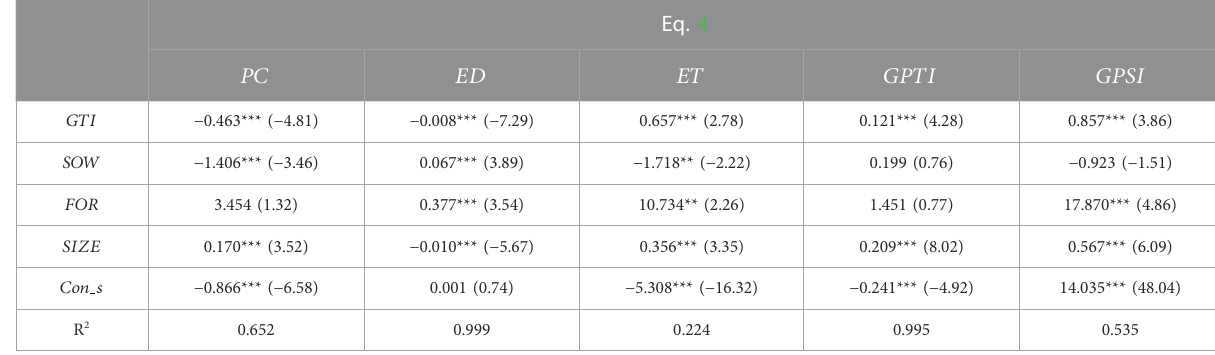
TABLE 8 Test results of impact paths.